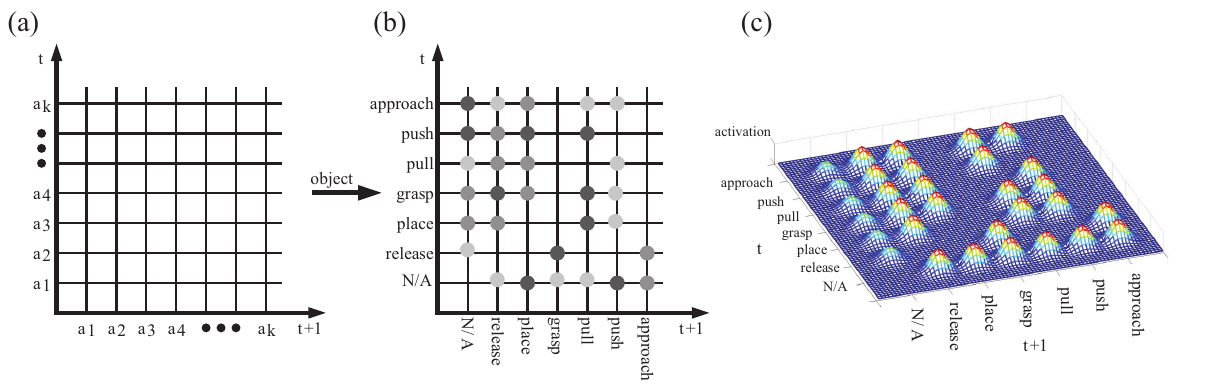
Figure 13. Connectivity field. a) General structure of the connectivity field for k actions a . b) Connectivity field for objects. Gray points represent connections between the current action at t and possible future actions at t + 1. Different shades have been chosen in order to represent that different connection strengths are possible.